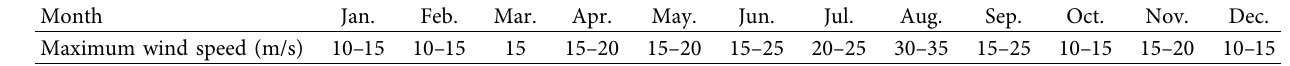
Table 4: Monthly distribution of maximum wind speed of Wenli freeway.